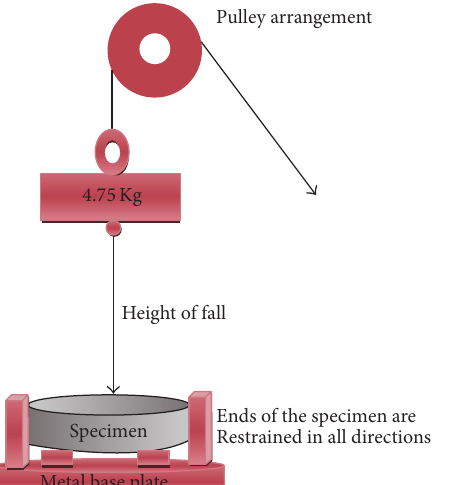
Figure 5: Setup of impact strength test for slag based geopolymer concrete.